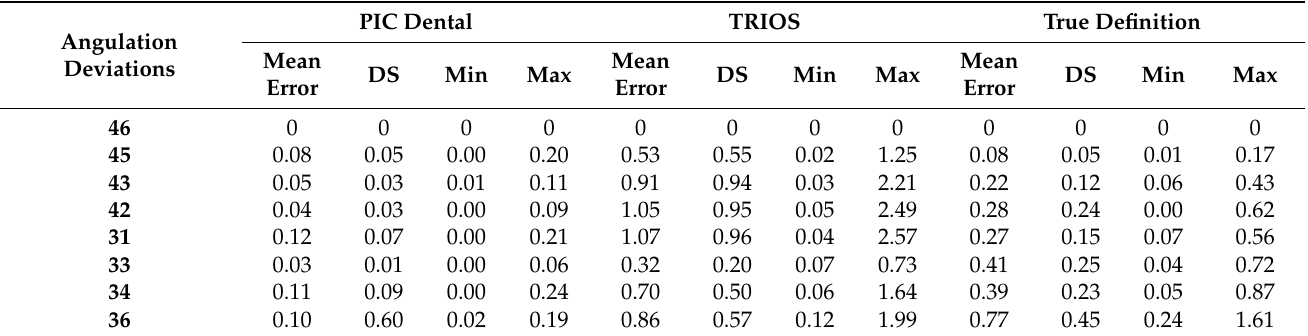
Table 6. Descriptive statistics for each of seven relative angulations (degrees) of mandibular arch obtained with the three evaluated systems.